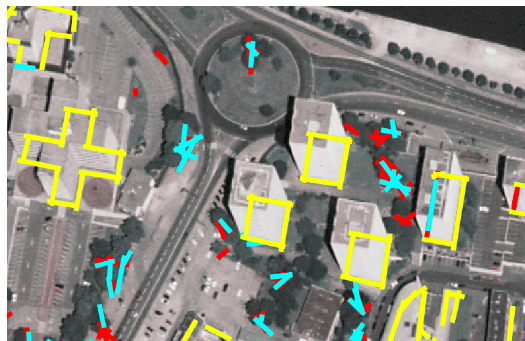
Figure 3: Vegetation filtering. Red segments are discarded using orientation criterion (RANSAC procedure), blue segments with planar criterion. Yellow segments are can be